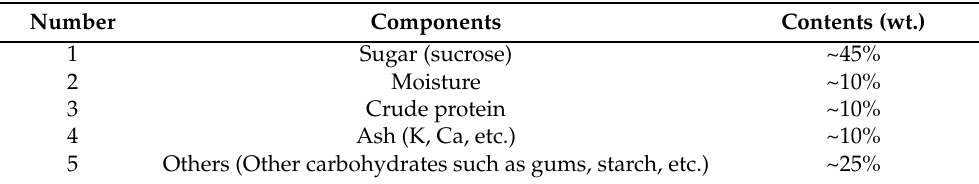
Table 2. The main components and their content in sugarcane